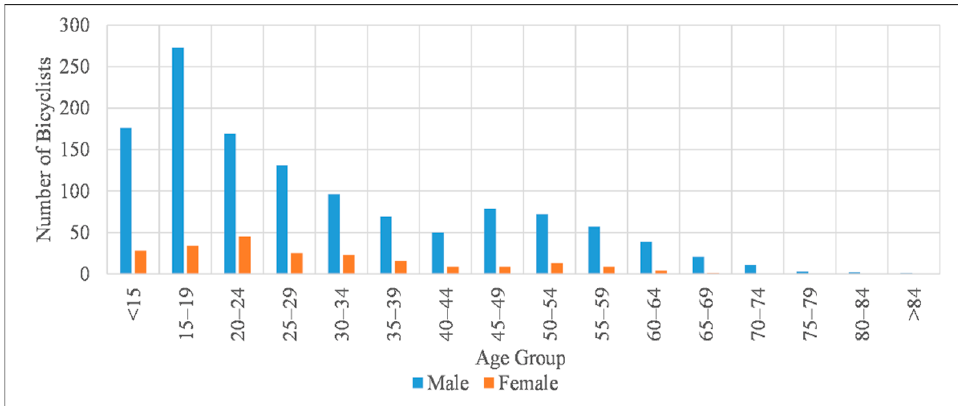
Figure 7. Age and gender distribution of bicyclists involved in crashes. Table 2. Proportions of bicyclist KA and KAB crashes in San Antonio from 2014–2018 corresponding to environmental, temporal, and road-related variables—Inter/Y and Inter/N denote at and not at intersection, respectively; 25 mph refers to the roadway speed